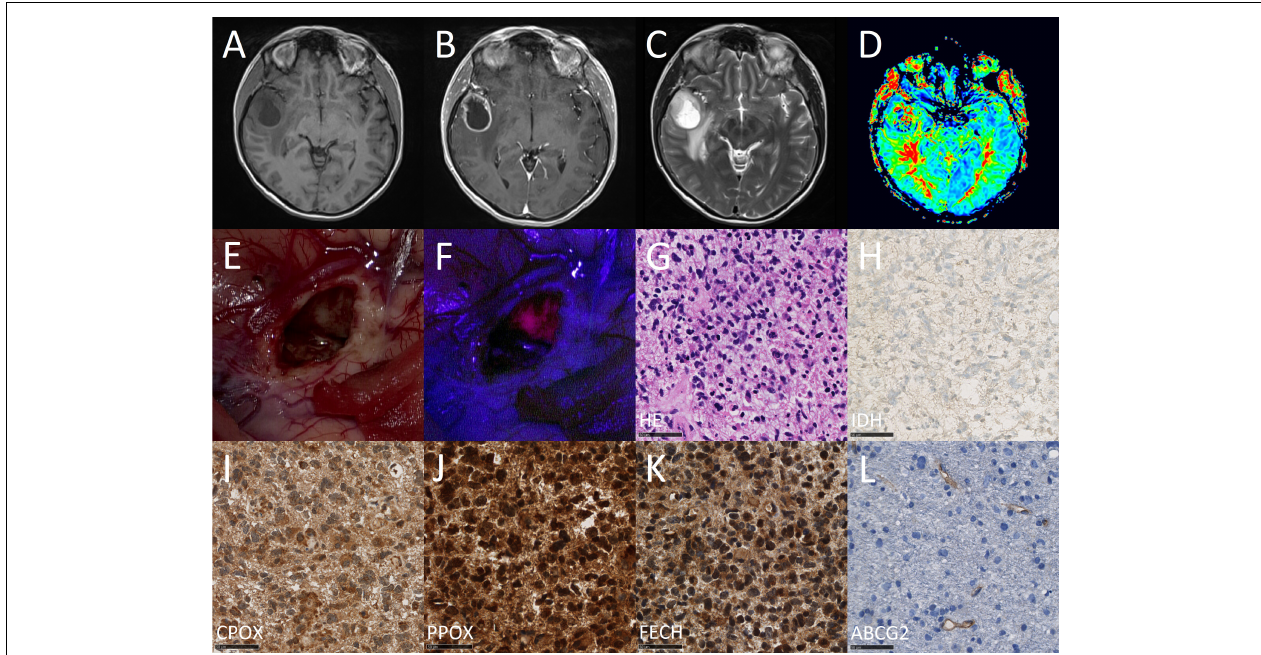
FIGURE 4 | Case illustration of a typical patient from the fluorescing group. The images are obtained from the case of a 68-year-old female patient that underwent 5-ALA fluorescence-guided resection of a suspected high-grade glioma. In the first row, preoperative magnetic resonance imaging (MRI) including T1-weighted images before (A) and after (B) contrast-medium application as well as a T2-weighted image (C) and perfusion image (D) are shown. In the second row, the intraoperative situs is shown under conventional white light (E) and violet-blue excitation light (F) as well as routine histopathological analysis including H&E staining (G) and IDH mutation immunohistochemistry (H) . In the third row, study specific immunohistochemical stainings are shown including CPOX (I) , PPOX (J) , FECH (K) , and ABCG2 (L)